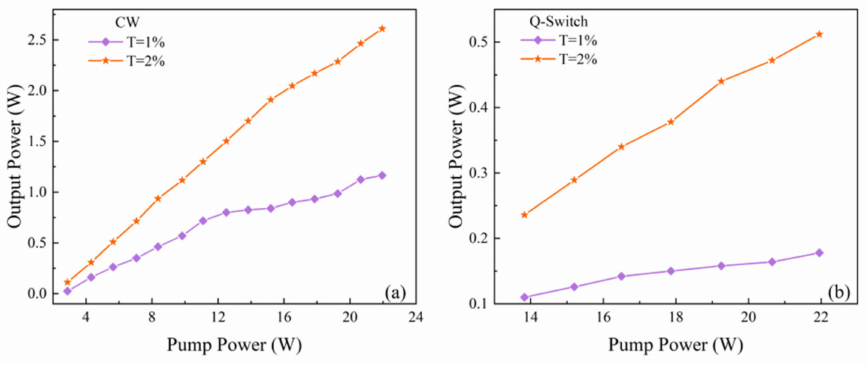
Figure 3. ( a ) The output power of CW Yb:CALGO laser. ( b ) The output power of pulsed Yb:CALGO laser using Mo:BiVO 4